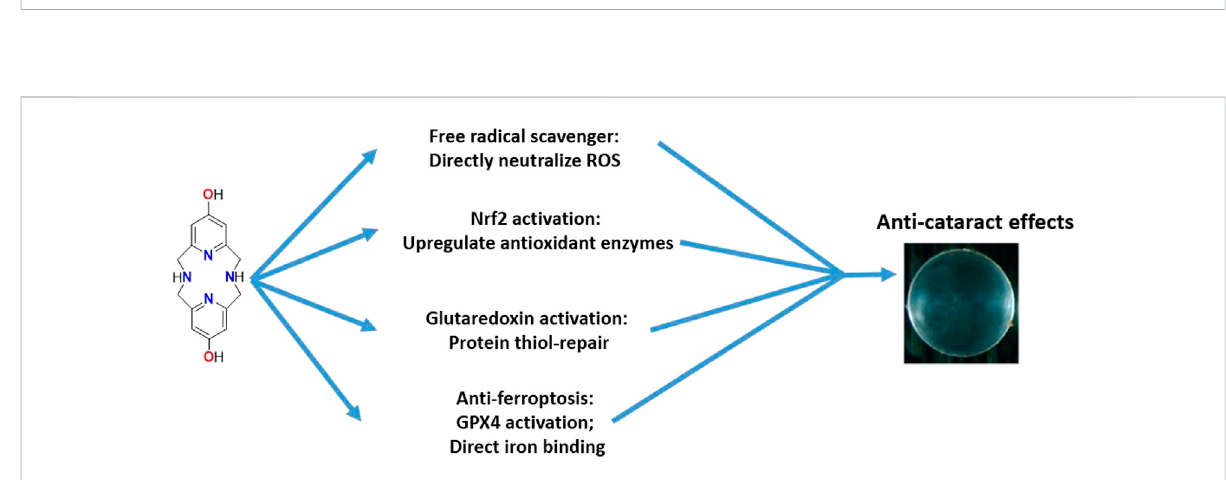
FIGURE 9 Multiple pathways are activated upon exposure to OH Py 2 N 2 that can result in protection against oxidative stress and cataract